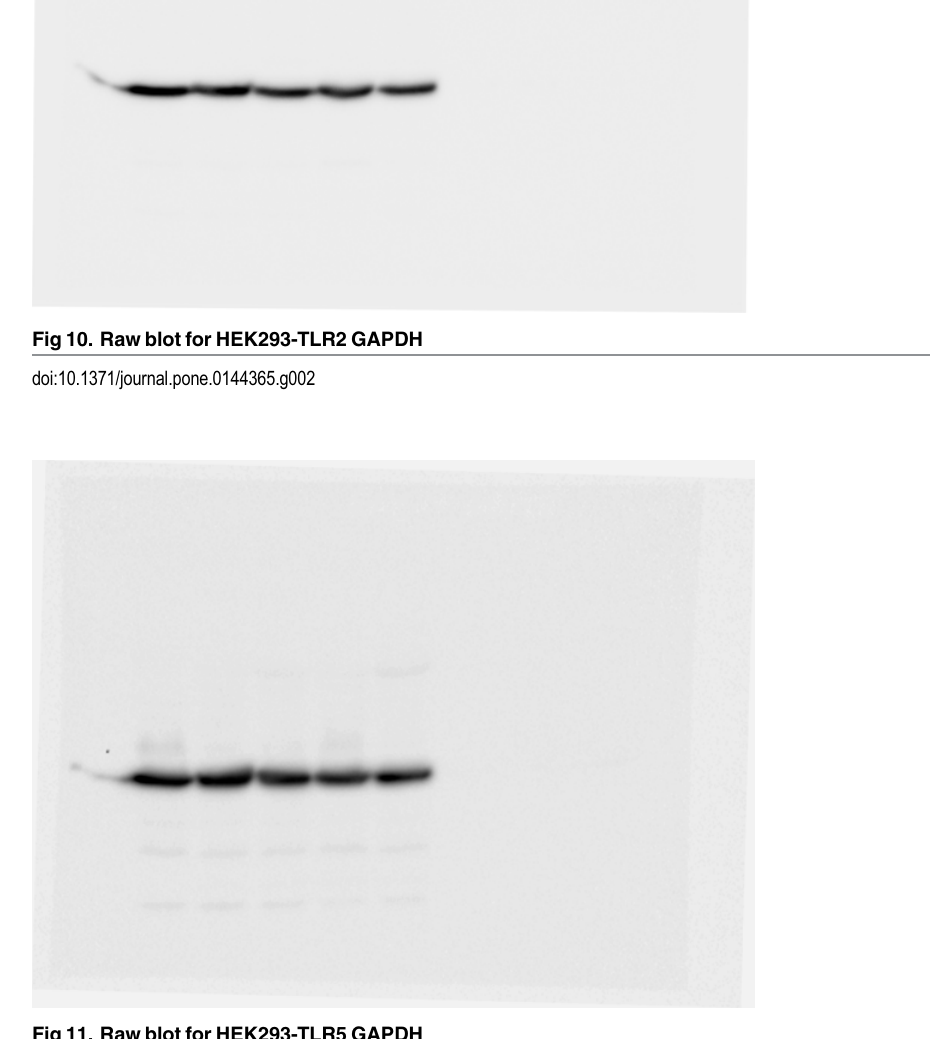
Fig 11. Raw blot for HEK293-TLR5 GAPDH